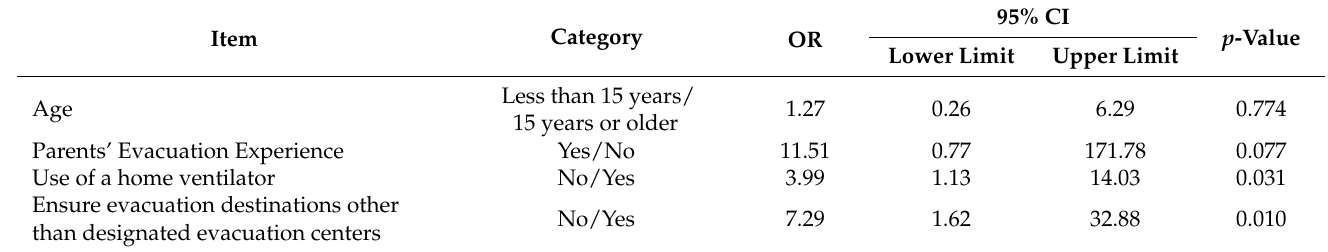
Table 2. Factors associated with evacuation intention: age, parents’ evacuation experience, use of home mechanical ventilation, and securing evacuation sites other than a public